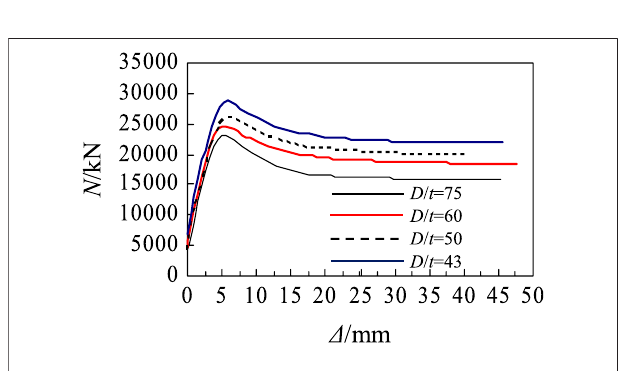
FIGURE 8 | The in fl uence of fi re time on N - Δ curve. FIGURE 9 | The in fl uence of D / t on N - Δ